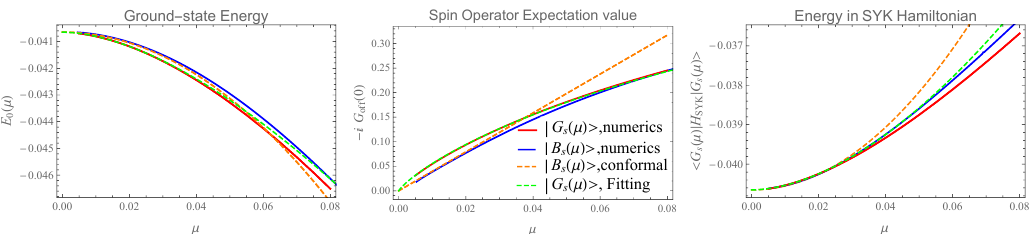
G s ( (cid:22) ) and the variational j i S k , which is equal to the (cid:28) = 0 j h i j